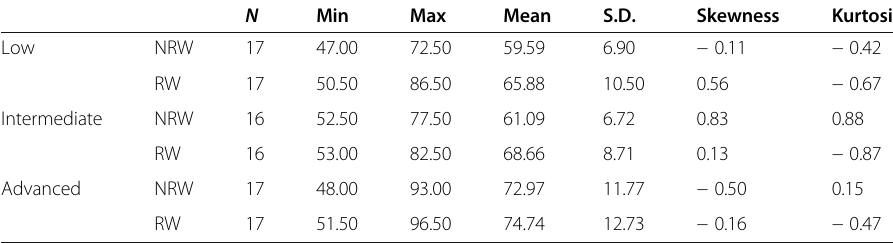
Table 4 Descriptive statistics of test takers ’ test scores by proficiency N Min